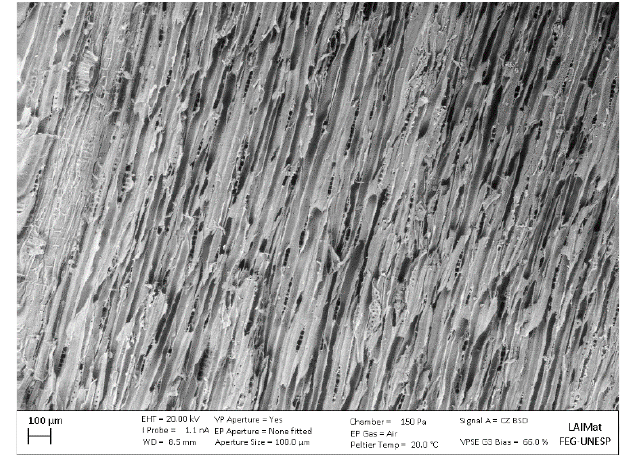
Figure 3. SEM image of veneer surface from control treatment.